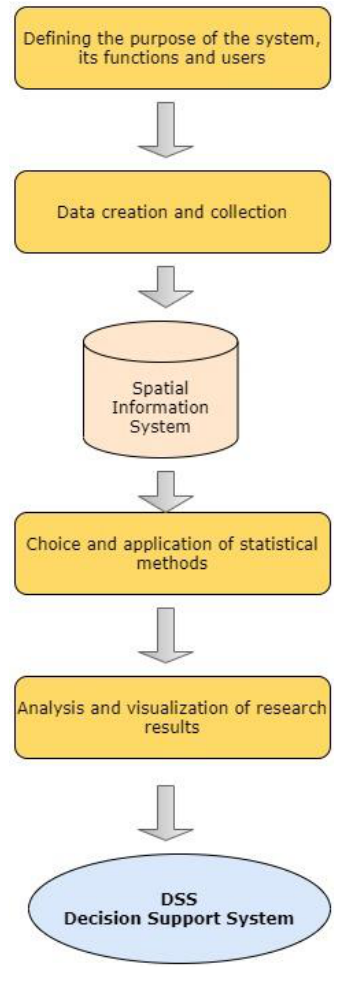
Figure 1. Scheme of system assumptions. Source: own study.